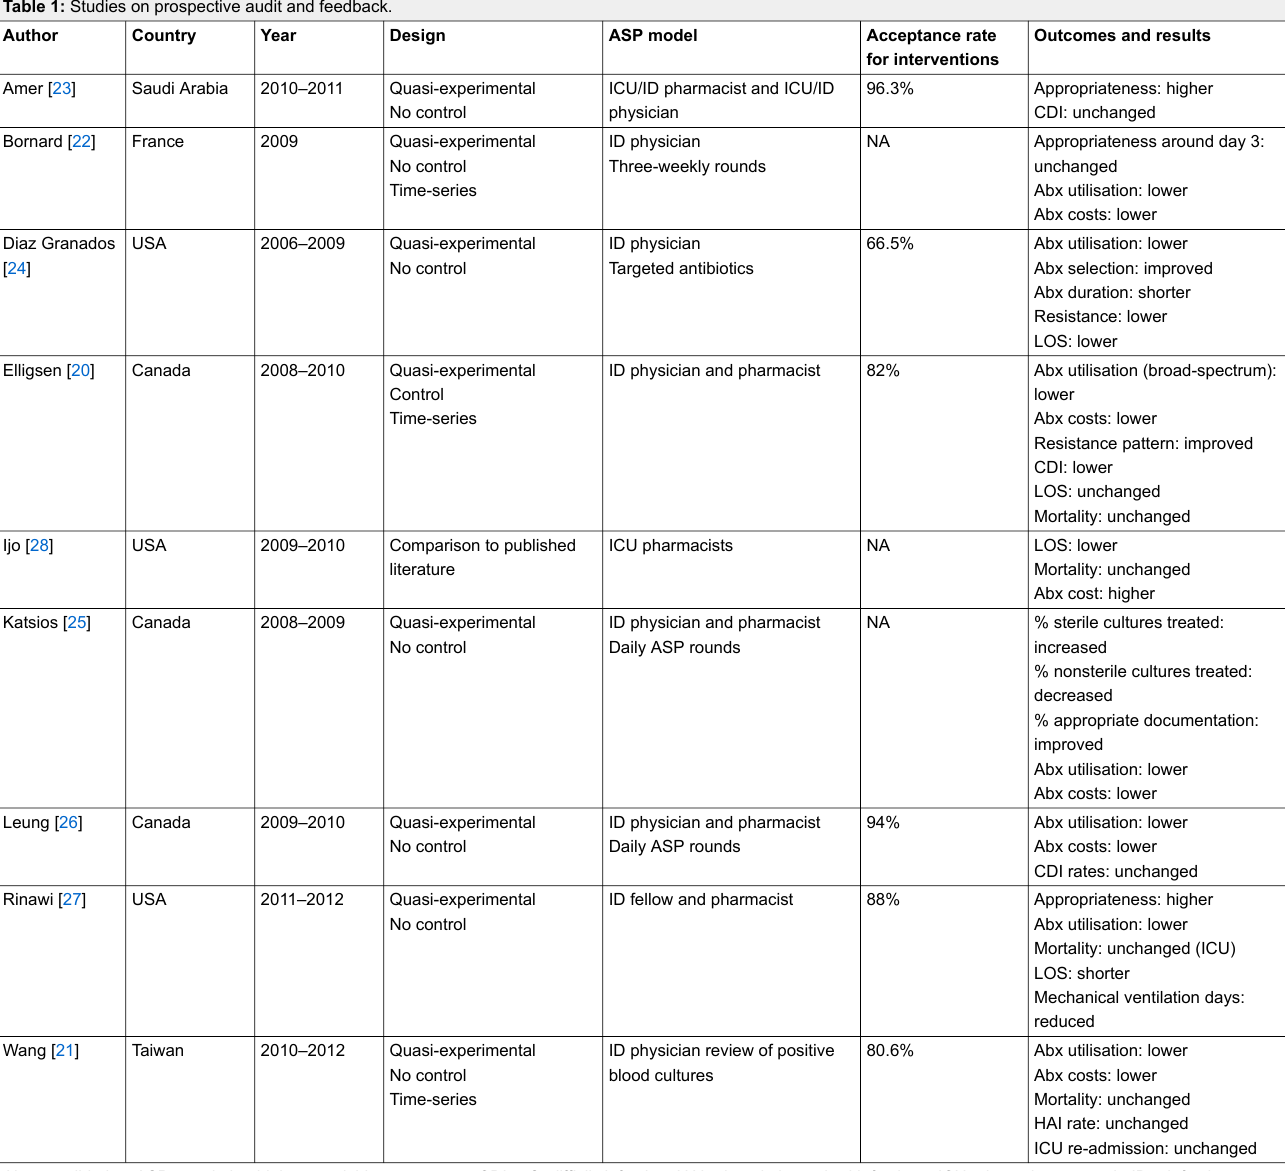
Table 1: Studies on prospective audit and